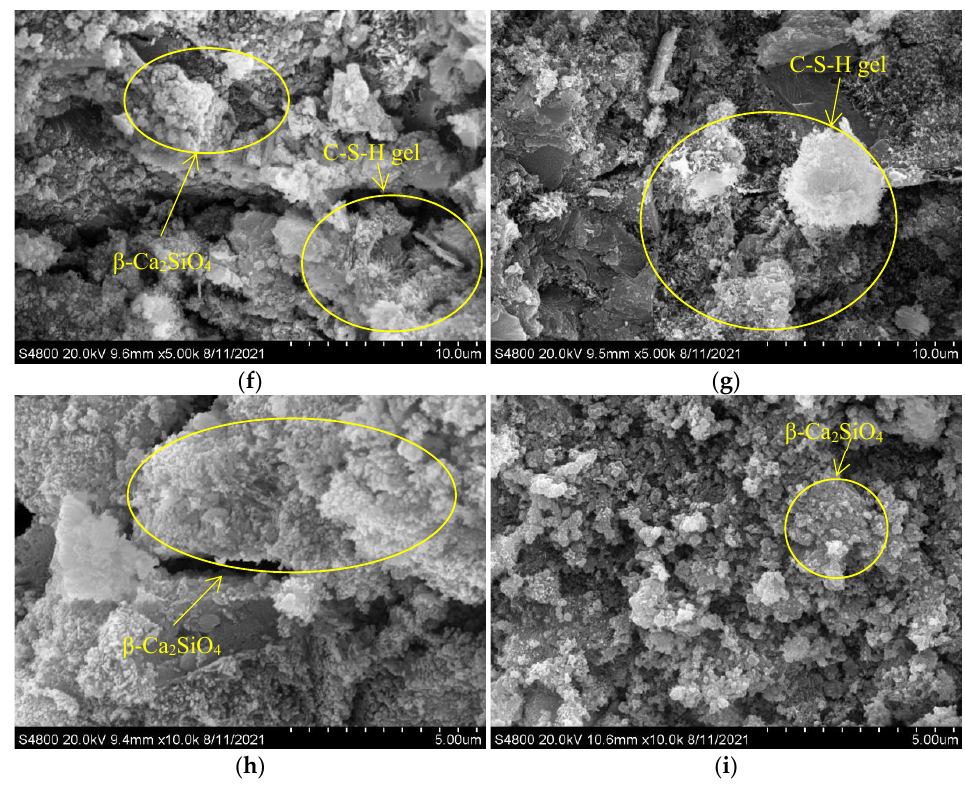
Figure 7. SEM analysis of concrete (water/cement ratio of 0.40). ( a ) 0.40–0/20–28 ◦ C, ( b ) 0.40–0–200 ◦